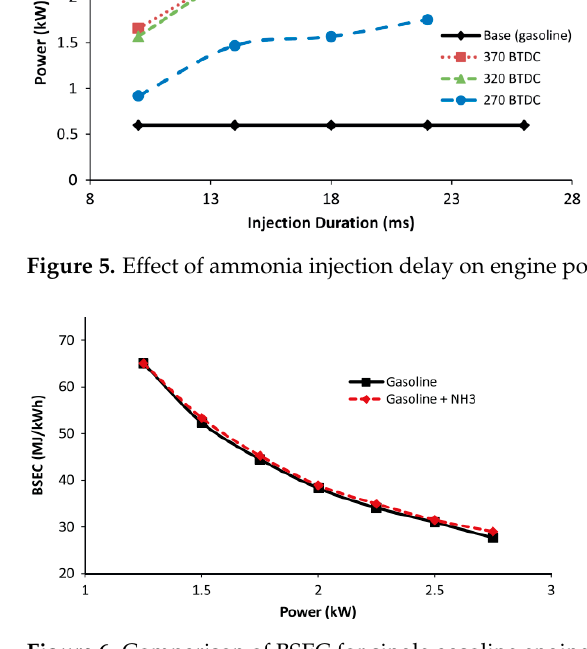
Figure 6. Comparison of BSEC for single gasoline engine and hybrid engine.